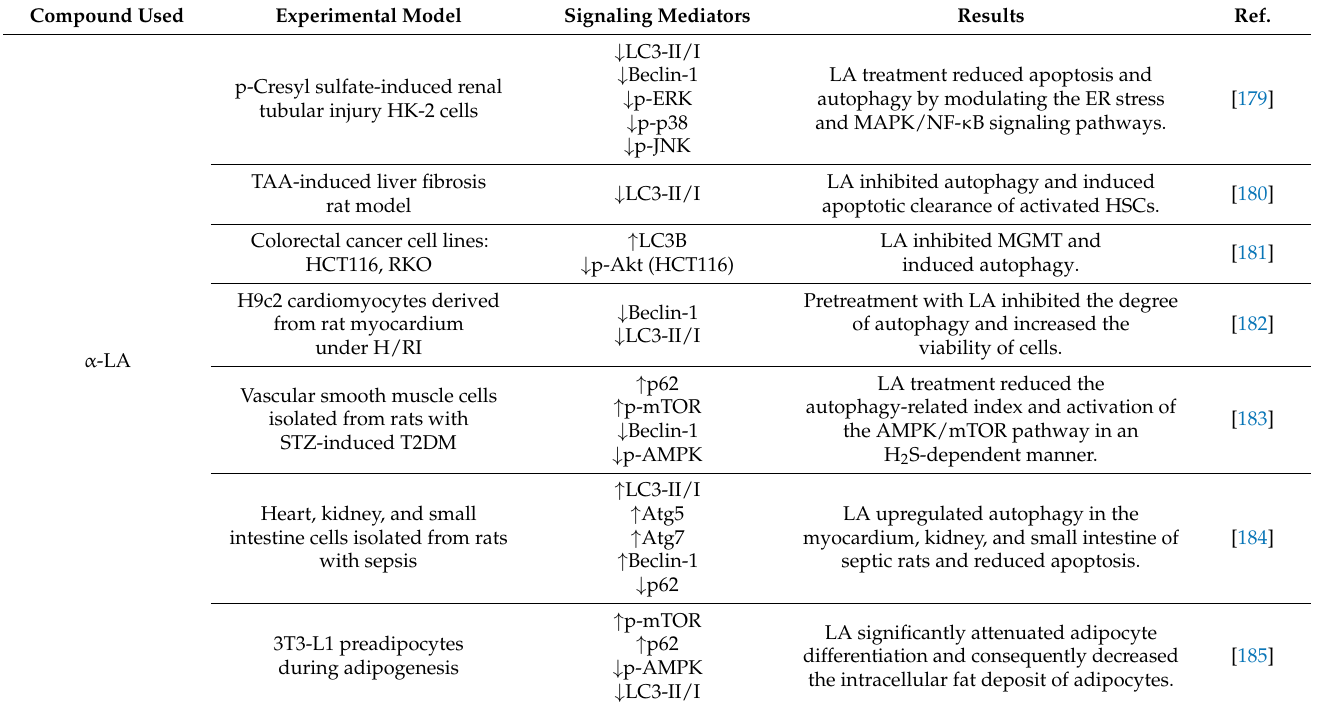
Table 7. Summary of selected available data on the LA-modulating activity of autophagy. Compound